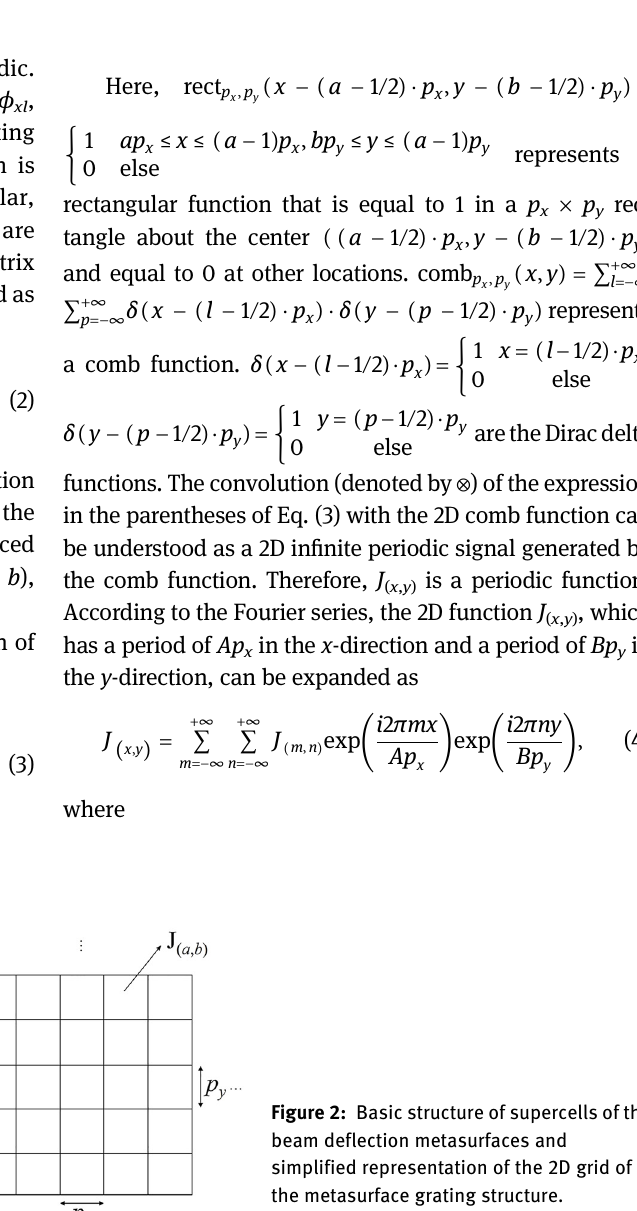
Figure 1: Dielectric nanopillar unit structure.